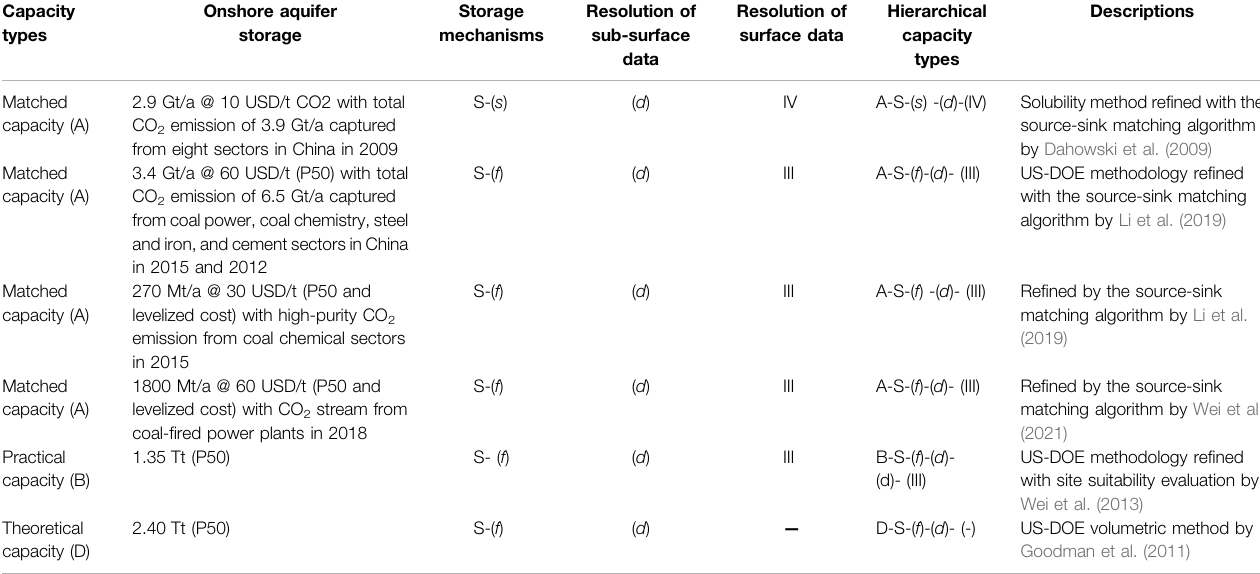
TABLE 6 | Hierarchical capacities of onshore CO 2 aquifer storage in